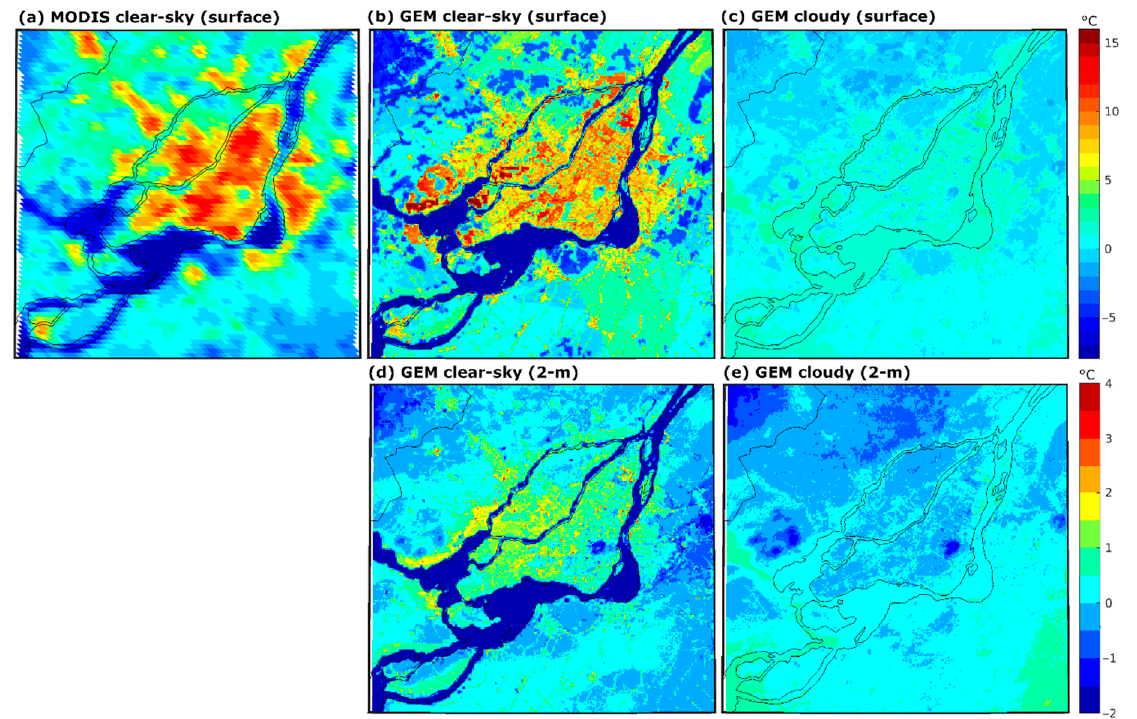
Figure 3. Magnitude of the surface urban heat island (UHI) during summer (JJA) in ( a ) MODIS and ( b ) the GEM100 simulation in daytime clear-sky conditions (GEM: 1 p.m., cloud fraction < 5% between noon and 1 p.m.). ( c ) Same as ( b ), but for cloudy conditions (cloud fraction > 80%). ( d ) Magnitude of the 2 m temperature UHI at 1 p.m. in clear-sky conditions. ( e ) Same as ( d ), but for cloudy conditions.